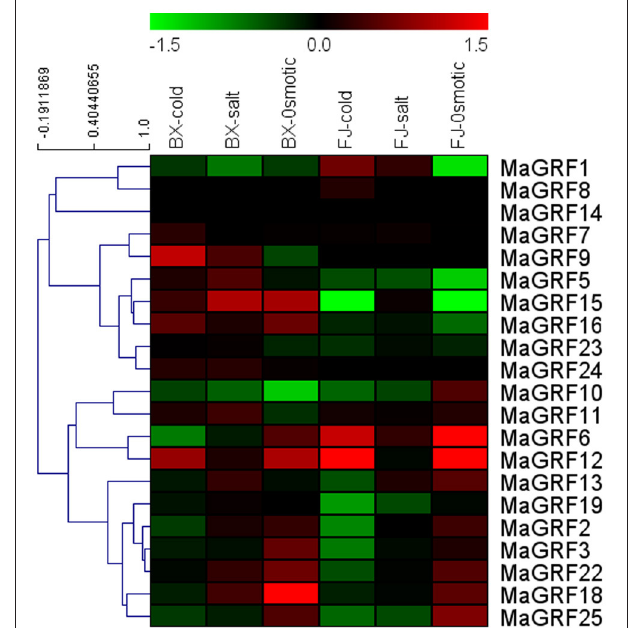
and osmotic treatments in two banana varieties. For osmotic and salt treatments, banana seedlings at the five-leaf stage grown in soil were irrigated with 200mM mannitol or 300mM NaCl for 7 days, respectively. For cold treatment, banana seedlings were cultured in a growth chamber with a temperature that was maintained at 4 ◦ C for 22h. Log 2 -based values were used to create the heat-map based on transcriptomic data of 14-3-3s from two independent experiments. The scale represents relative signal intensity